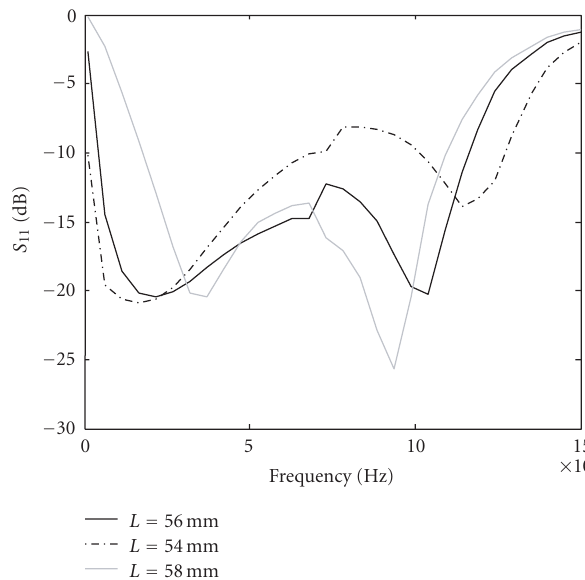
Figure 4: E ff ect of varying K to the antenna characteristic.